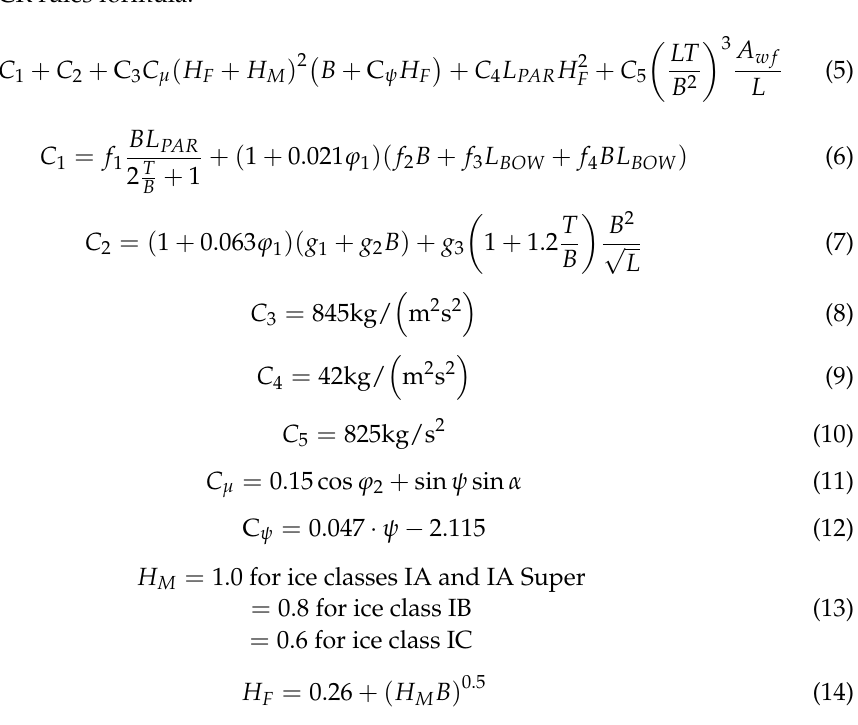
Table 2. Calculation parameters of different bow forms (Linqvist method and FSICR method).